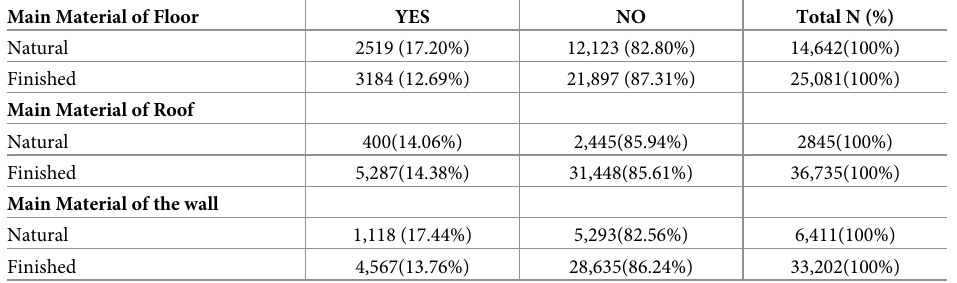
Table 3. Housing quality and percentage of children with fast, short, rapid or difficult breathing in the last two weeks in Punjab, Pakistan. Main Material of Floor